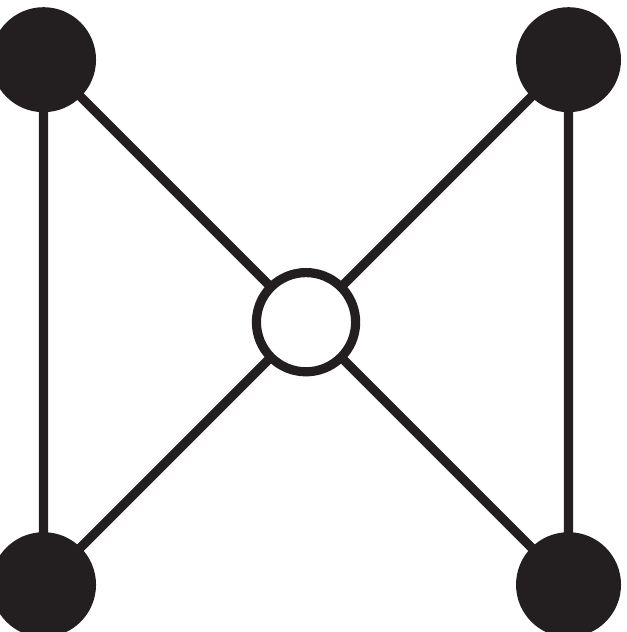
Fig 2. Graphlet 18. The black outer vertices form orbit 43, the white inner vertex is orbit 44.